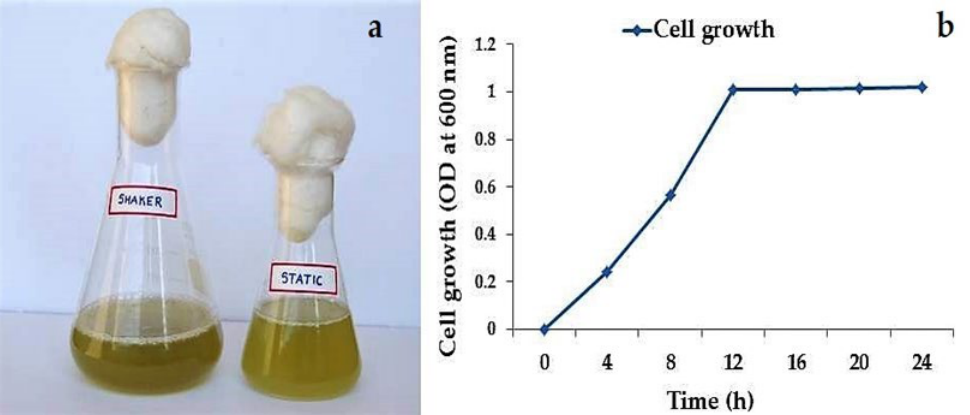
Figure 3. ( a ) Enzyme production and ( b ) cell growth characteristics of S. aureus CASMTK1. Effect of enzyme production based on incubation period in 100 mL of the modified Mannitol salt broth, placed in the 250 mL sterile flask and added with 25 µ L of hyaluronic acid in the medium. After sterilization by autoclaving, the flasks were cooled and inoculated with 5% v / v inoculum and incubated at 37 ◦ C on a rotary shaker at 150 rpm for 24 h and bacterial cell growth was observed. Table 1. Enzymatic activities of staphylococcal hyaluronidase turbidity assay.